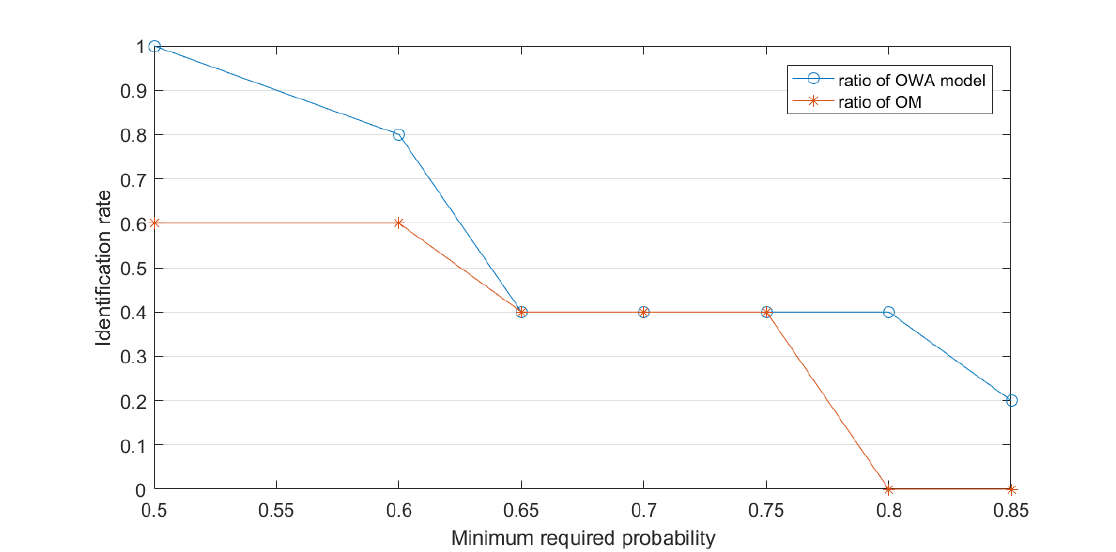
Figure 6. Results of Example